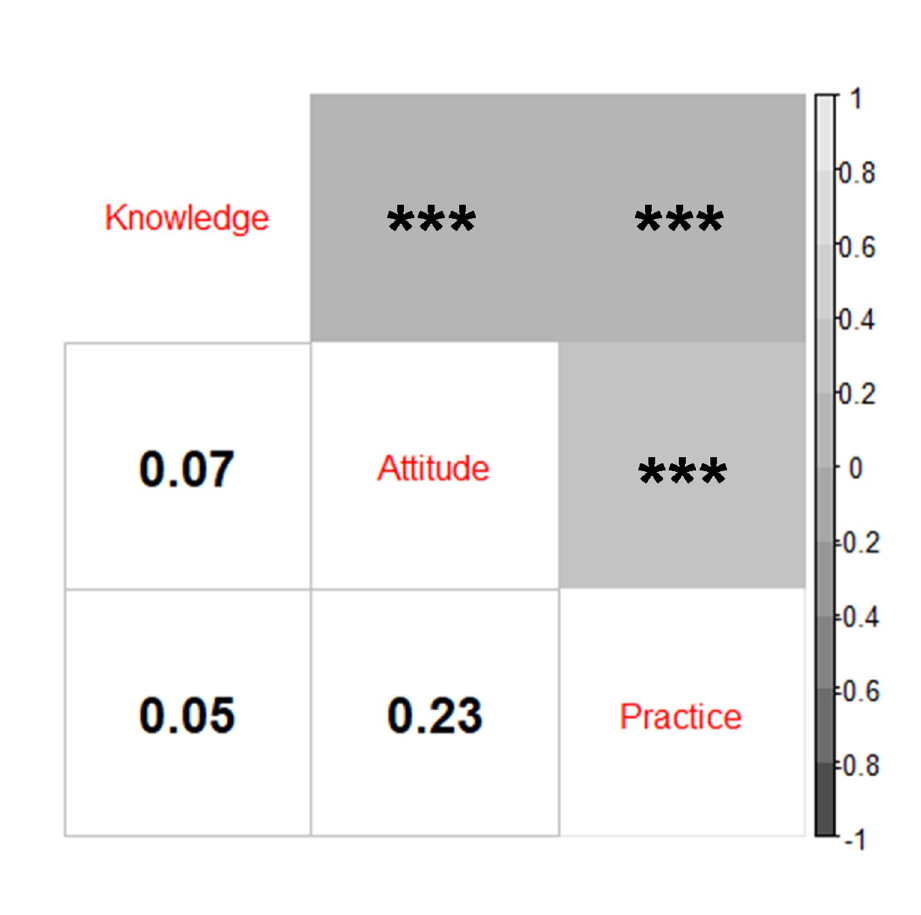
Fig 1. Correlation between knowledge, attitude, and practice toward COVID-19 in the study population. ��� p <